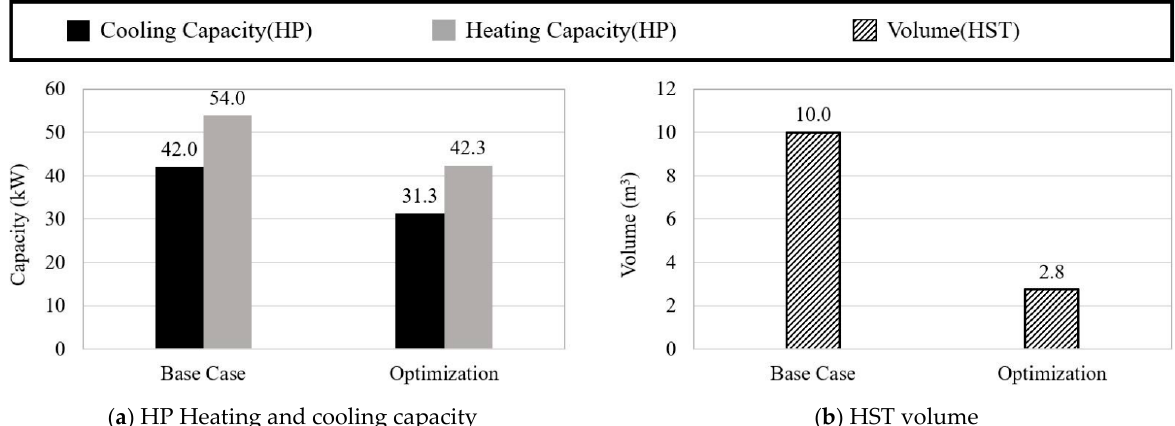
Figure 9. Comparison of optimization results; ( a ) comparison result between the existing design method and the optimized design method for the heating and cooling capacity of heat pumps, ( b ) comparison result between the existing design method and the optimized design method for the volume of the heat storage tank.